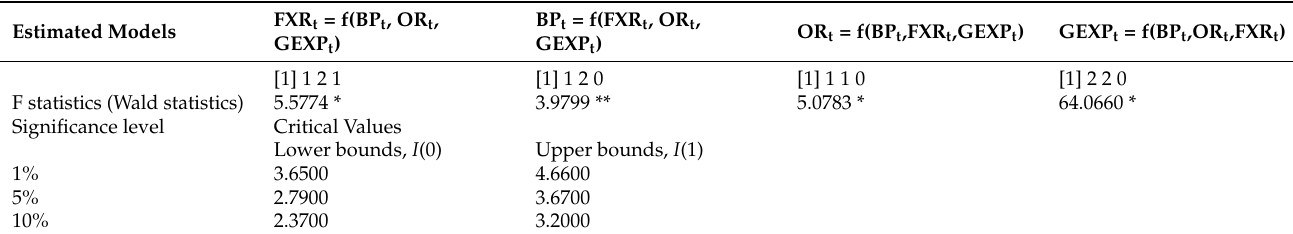
Table 2. Bounds F-test (Wald) for no cointegration with restricted intercept and no trend. Estimated